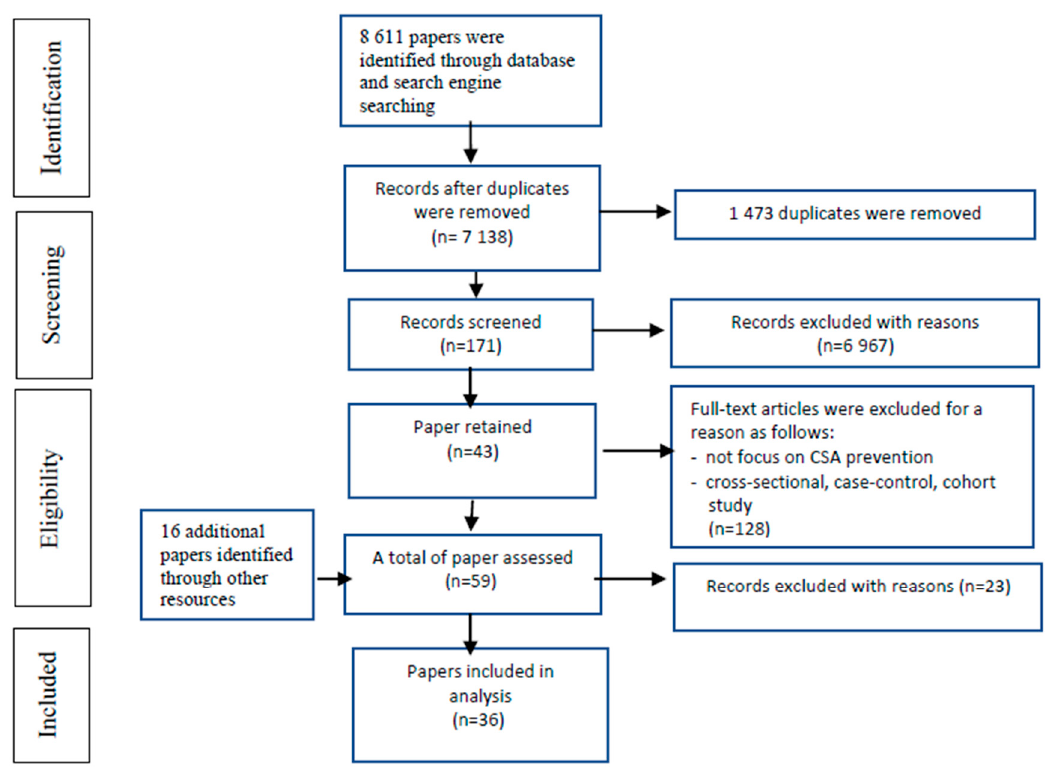
Figure 1. PRISMA flowchart of the review